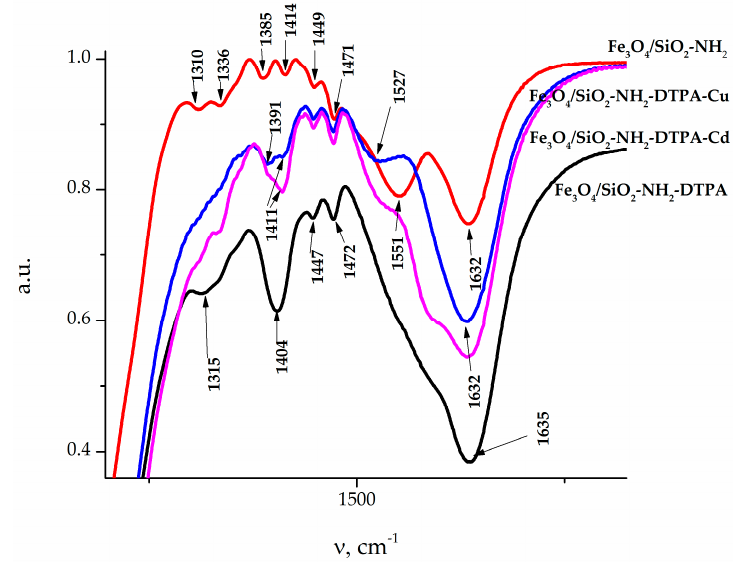
Figure 2. Fourier transform infrared spectroscopy (FTIR) spectra of the Fe 3 O 4 /SiO 2 -NH 2 (red), Fe 3 O 4 /SiO 2 -NH 2 -DTPA (black), and Fe 3 O 4 /SiO 2 -NH 2 -DTPA nanocomposites, bearing Cu 2+ (blue) and Cd 2+ (purple).